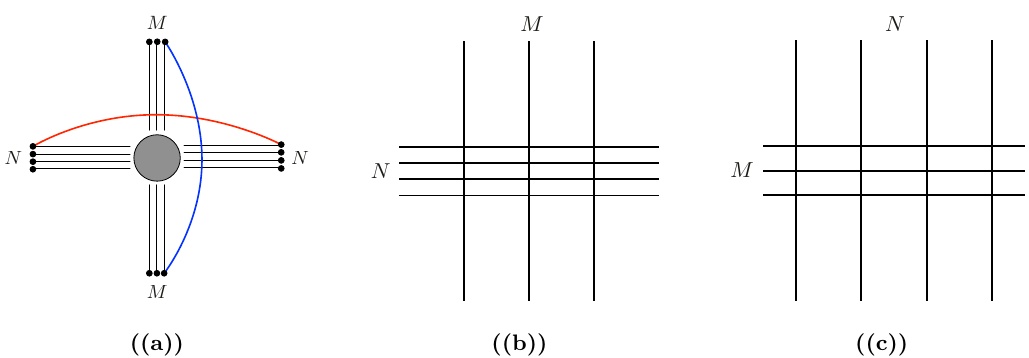
Figure 4. The 5-brane web of the + N;M theory: (a) The theory at the (cid:12)xed point, with the string and D1-brane representing the bi-fundamental operators. (b) The deformation leading to the SU( N ) quiver. (c) The deformation leading to the SU( M )